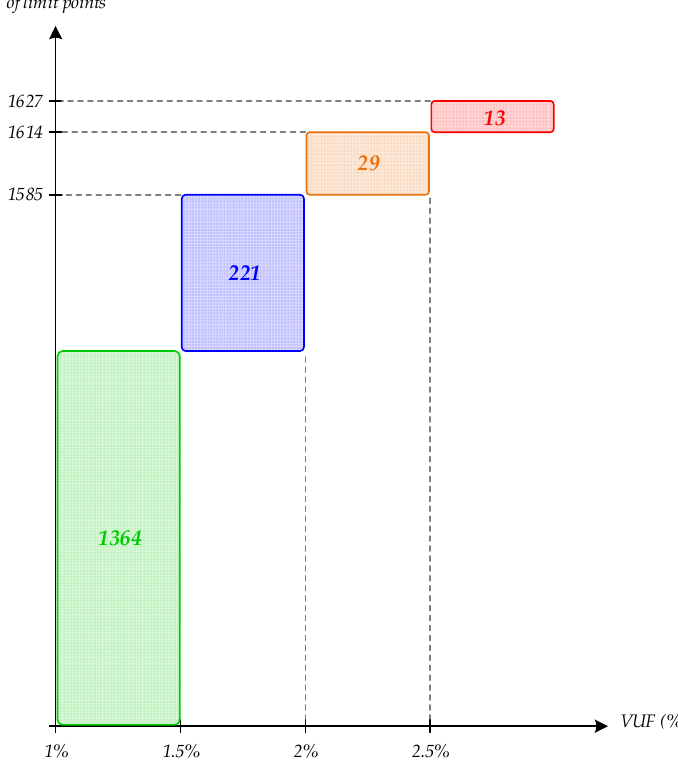
Figure 6. Number of out-of-limit operating points vs. VUF without balancing system over one year.